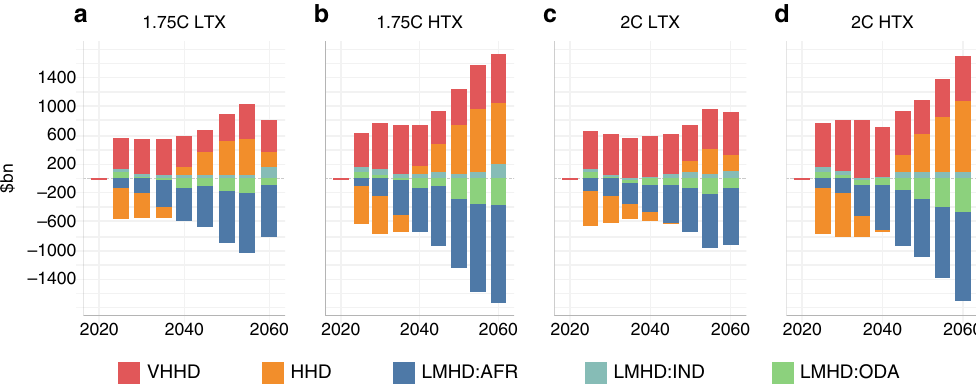
Fig. 3 Change in commodity trade costs under 1.75 and 2 °C HDI-based redistributed cases relative to optimal cases, 2020 – 2060. Panels a – d show the change in commodity trade costs by HDI group, compared with the cost-optimal case, re fl ecting the balance between export revenues and import costs. The net level is zero in all cases. Negative values show an increase in net exports. Trade cost estimates do not include tax revenues raised by the production tax, with the focus on the techno-economic costs of the system. Source data are provided as a Source data fi